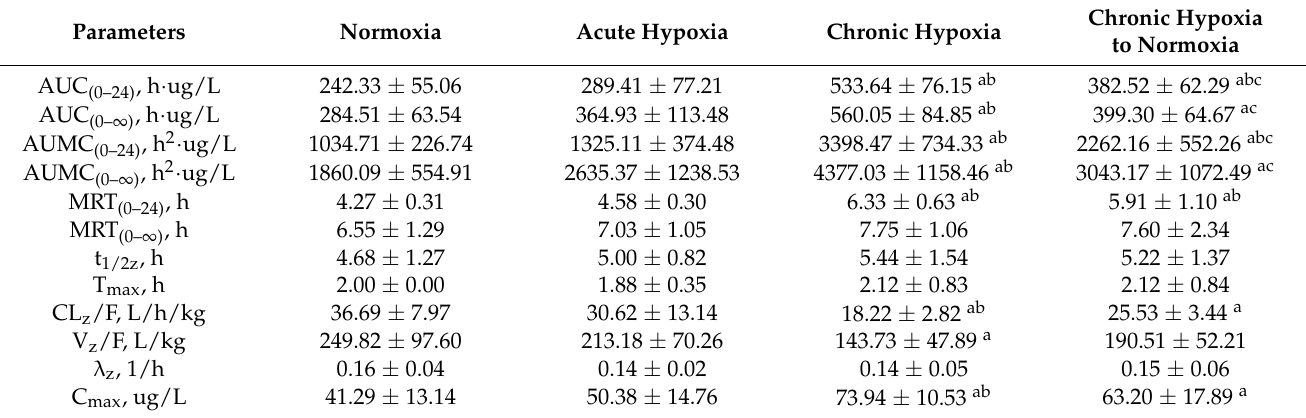
Table 2. Pharmacokinetic parameters of simvastatin hydroxy acid in rat plasma after exposure to high-altitude